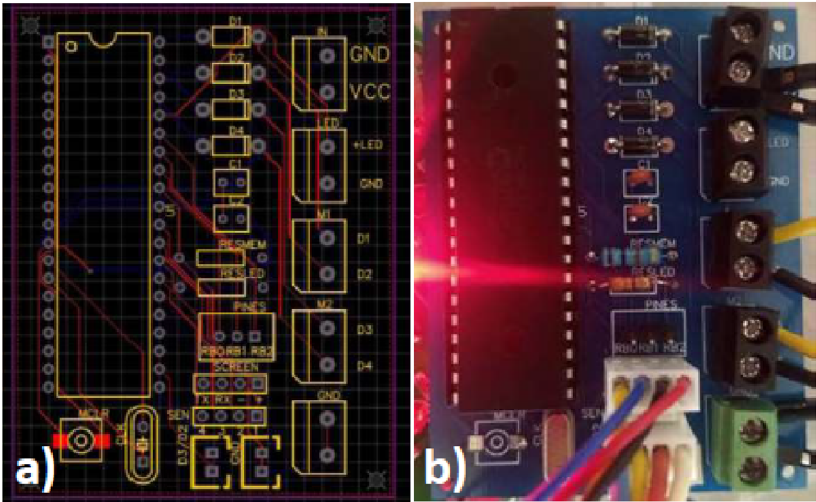
Figure 11. Schematic of the electronic circuit ( a ) and printed circuit board PCB ( b ).